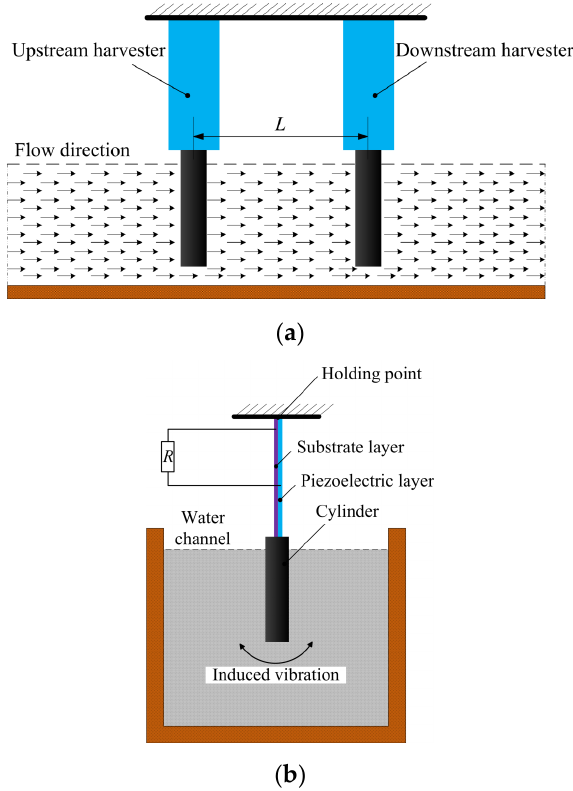
Figure 2. Schematic of the harvesting system with two tandem identical piezoelectric energy harvests: ( a ) Tandem configuration diagram; ( b ) Composition diagram of each harvester. Table 1. Material properties of the piezoelectric energy harvesters.